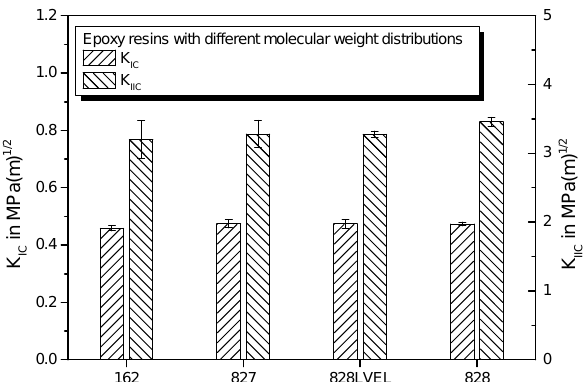
Figure 13. Comparison of fracture toughness in mode I and mode II for epoxy resins Epikote 162, 827, 828LVEL, and